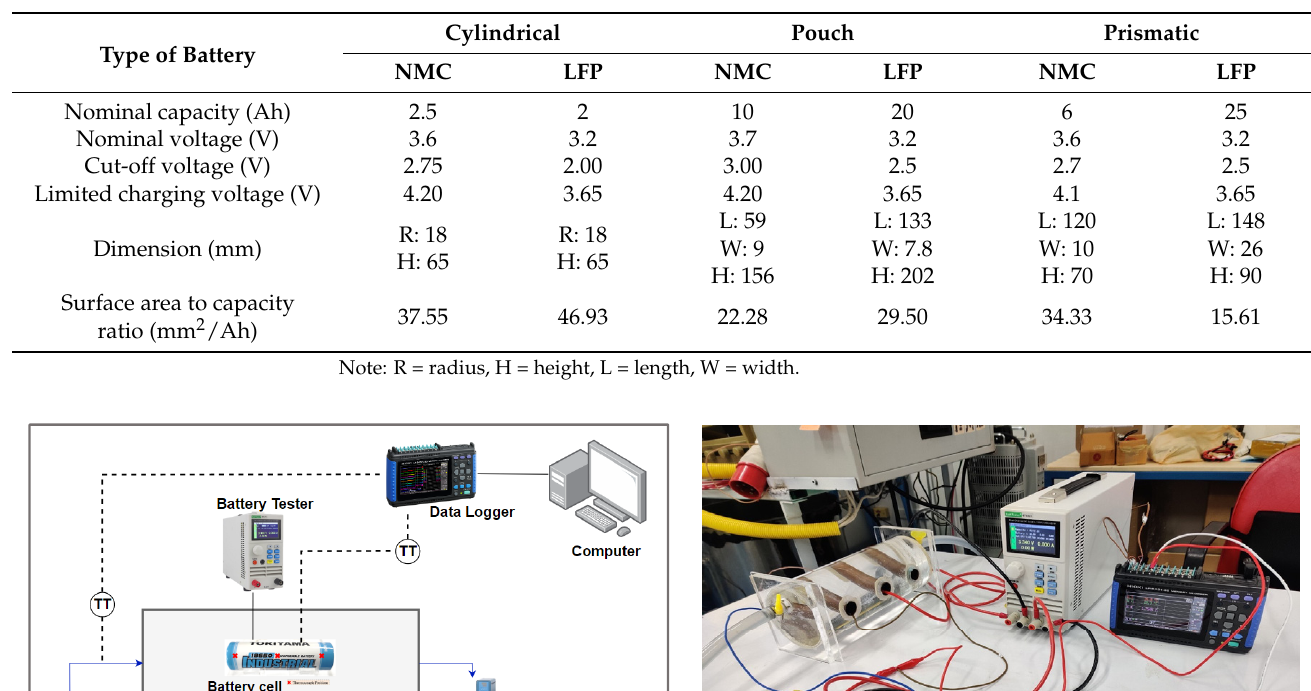
Table 1. The specification of Li-ion battery cells.